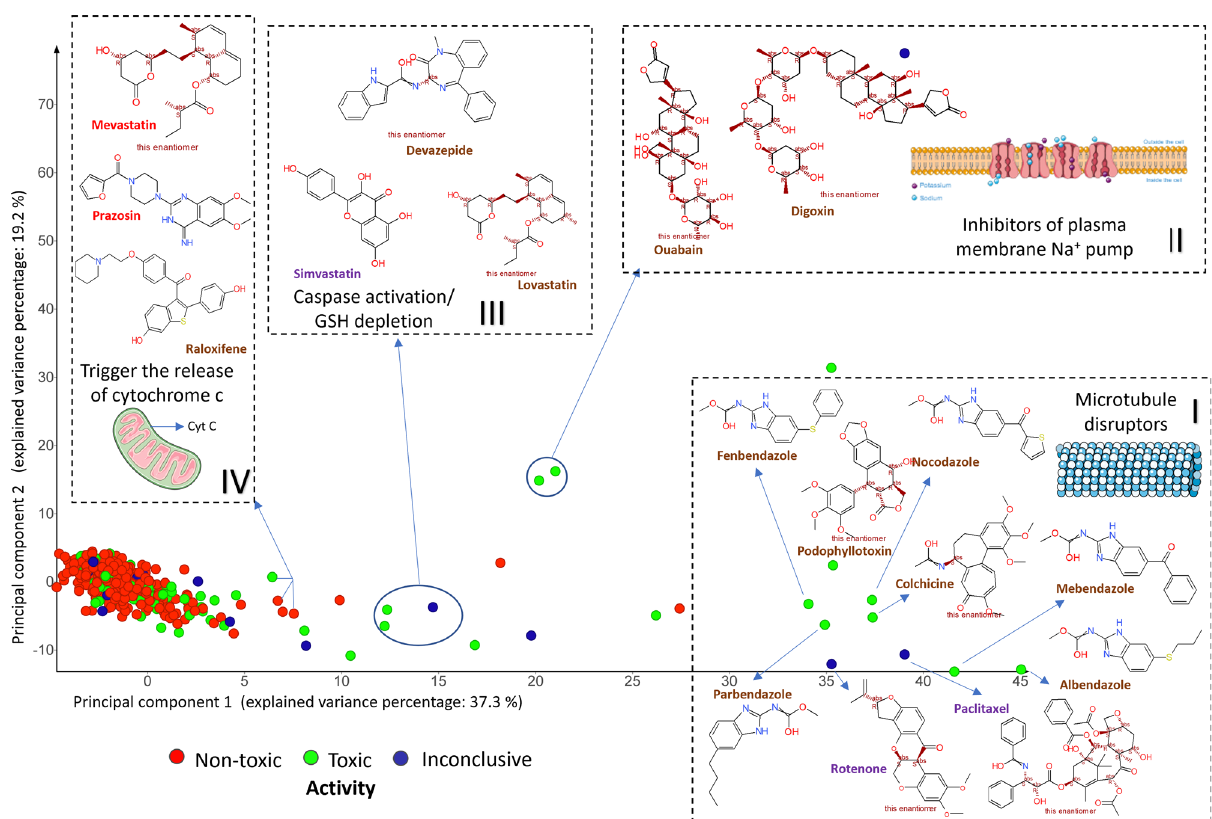
Fig. 4 Compound having similar mechanisms of action cluster in morphological space. Principal Component Analysis of 542 compounds in 110- dimensional Cell Painting feature space. Certain compounds clustered further away from the distribution of majority of compounds having similar mechanisms of actions such as of microtubule destabilizers, or compounds inducing apoptotic signalling cascades, compounds causing oxidative stress due to GSH depletion or those that are inhibitors of plasma membrane Na + pump (all of which reduce mitochondrial membrane potential). Cluster I (microtubule destabilisers): rotenone, albendazole, parbendazole, mebendazole, nocodazole, fenbendazole, colchine, paclitaxel and podophyllotoxin; Cluster II (inhibitors of plasma membrane Na + pump): ouabain and digoxin; Cluster III (caspase activation and GSH depletion): devazepide,